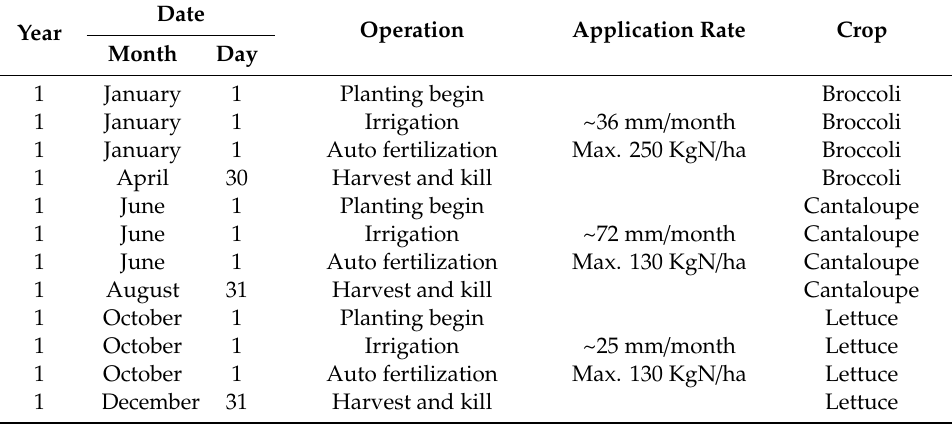
Table 3. Schedule of management and rotation practices in agricultural land